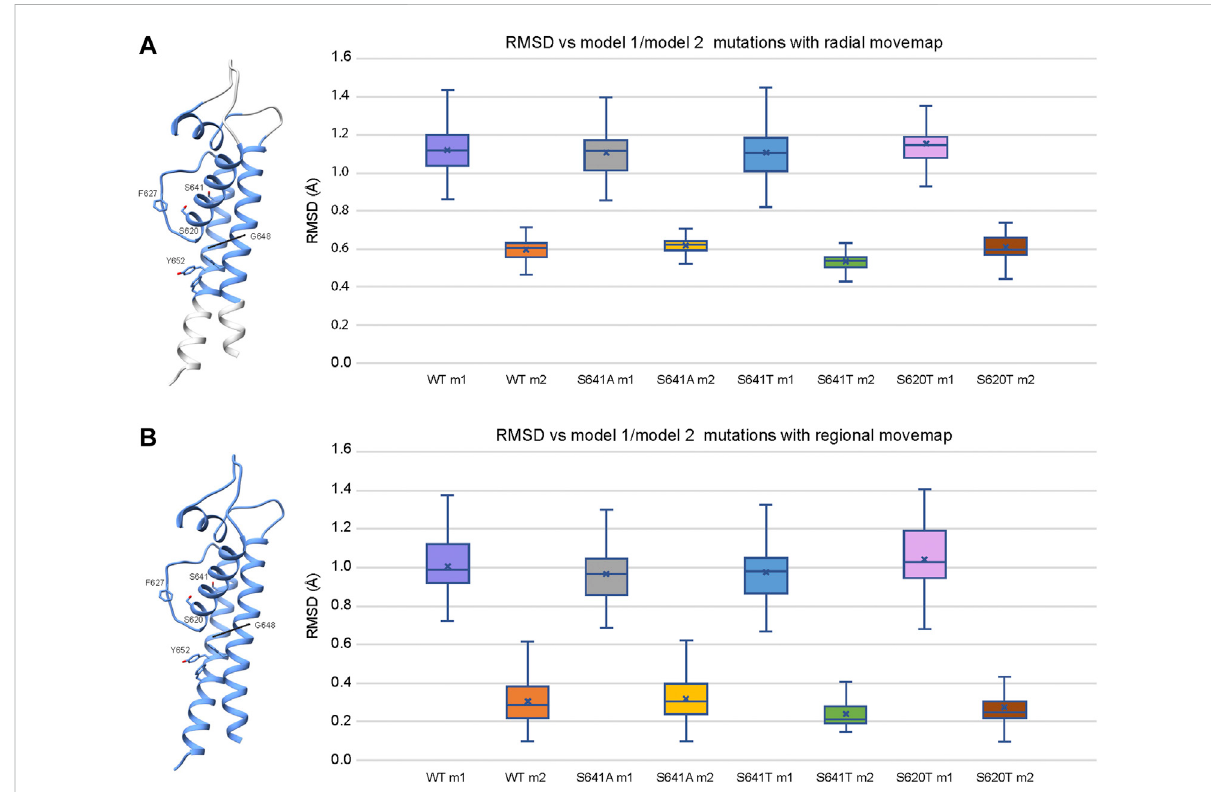
FIGURE 9 RelativestabilityofWTandmutantmodelsusingthe (A) radialand (B) regionalmovemaps.Singledomainrepresentationsareshownonleftwith regionsspeci fi edasmovablebymovemapdepictedinblue,andkeyresidueslabeled.RMSD:C α root-mean-squaredeviationinAngstroms.RMSDfor m1 and m2 mutant models were measured against m1 and m2 WT hERG channel models, respectively. Error bars represent Max and Min values; Mean (x); Median (horizontal